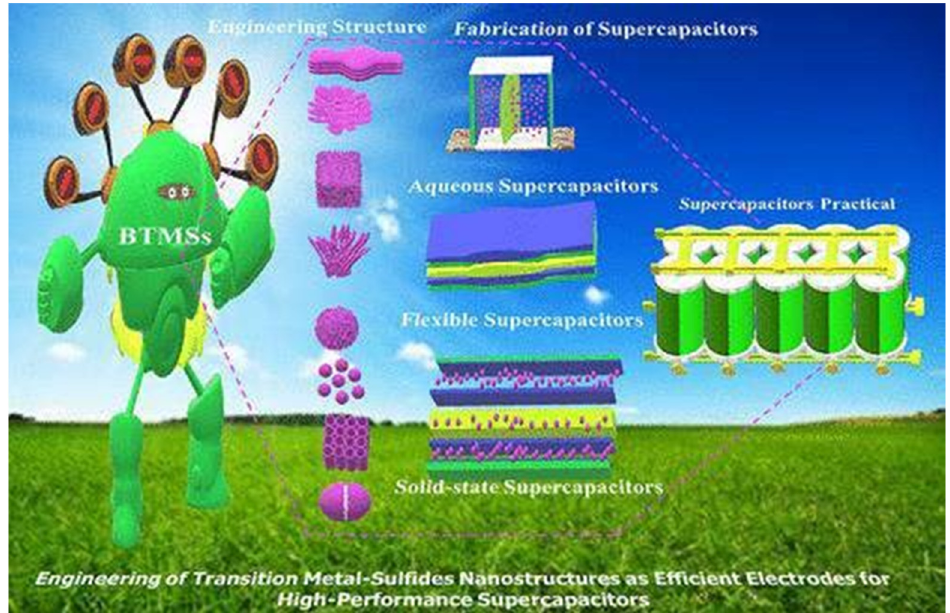
Figure 19. Efficient Electrodes for high-performance supercapacitors using transition-metal sulfide nanostructures. Reproduced with permission from [98].